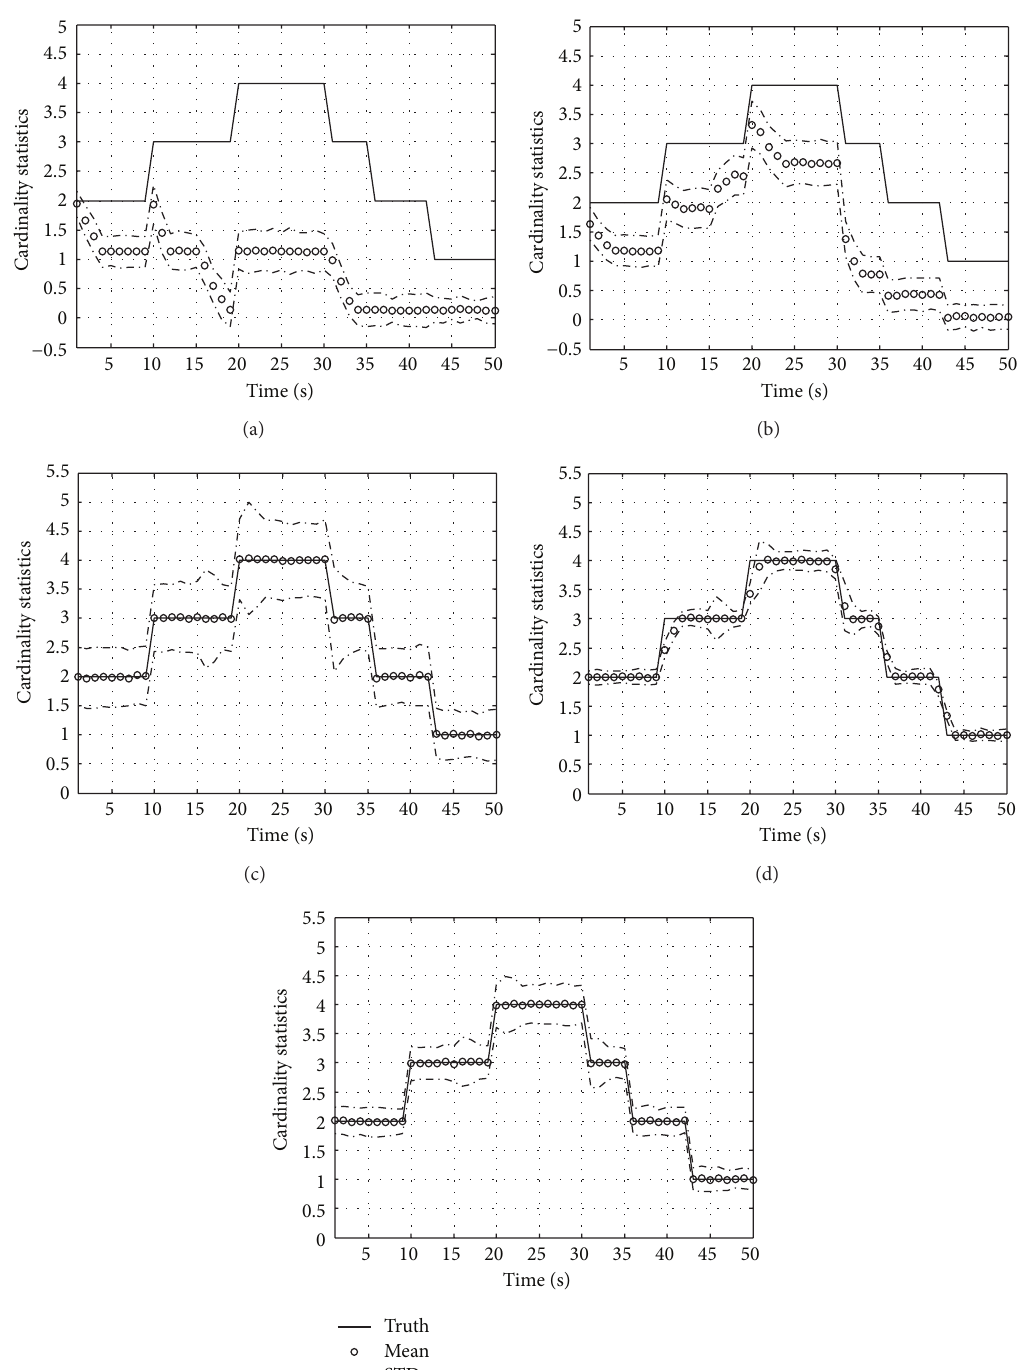
Figure 4: The 500 MC run averages of cardinality statistics versus time for the (a) CV model GM-CBMeMBer filter, (b) CT model GM- CBMeMBer filter, (c) GM-MM-PHD filter, (d) GM-MM-CPHD filter, and (e) GM-MM-CBMeMBer